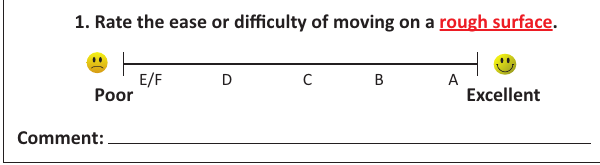
1. Rate the ease or difficulty of moving on a rough surface.